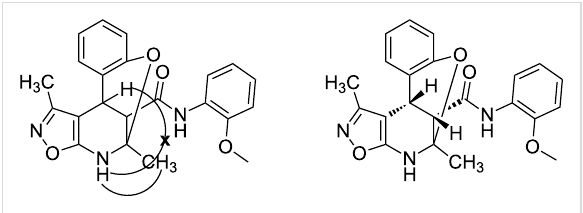
Figure 4: Selected data from NOESY experiments and relative stereo- chemistry of stereogenic centers at positions 4 and 12.